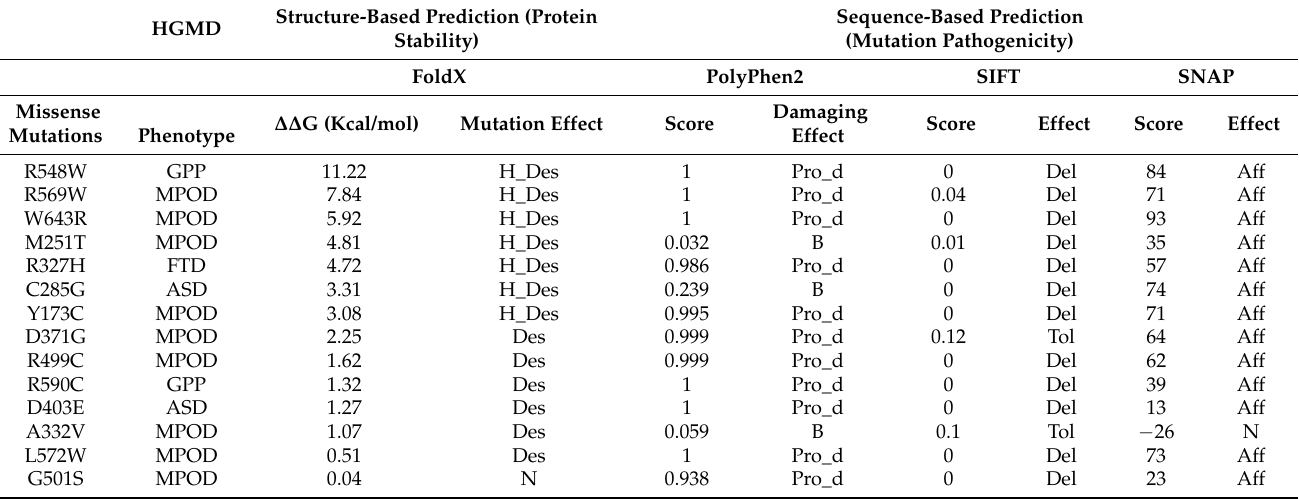
Table 2. Sequence-based and structure-based prediction of disease-associated missense